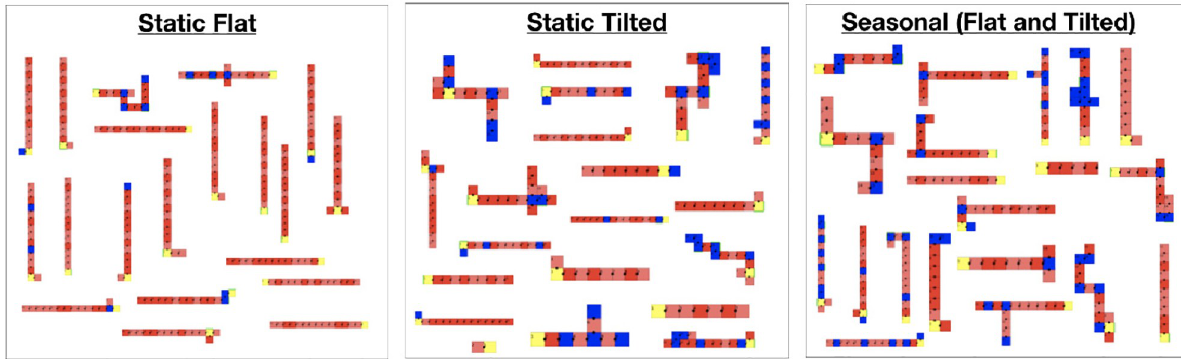
Fig 14. Best robot of each experiment repetition in the different environmental